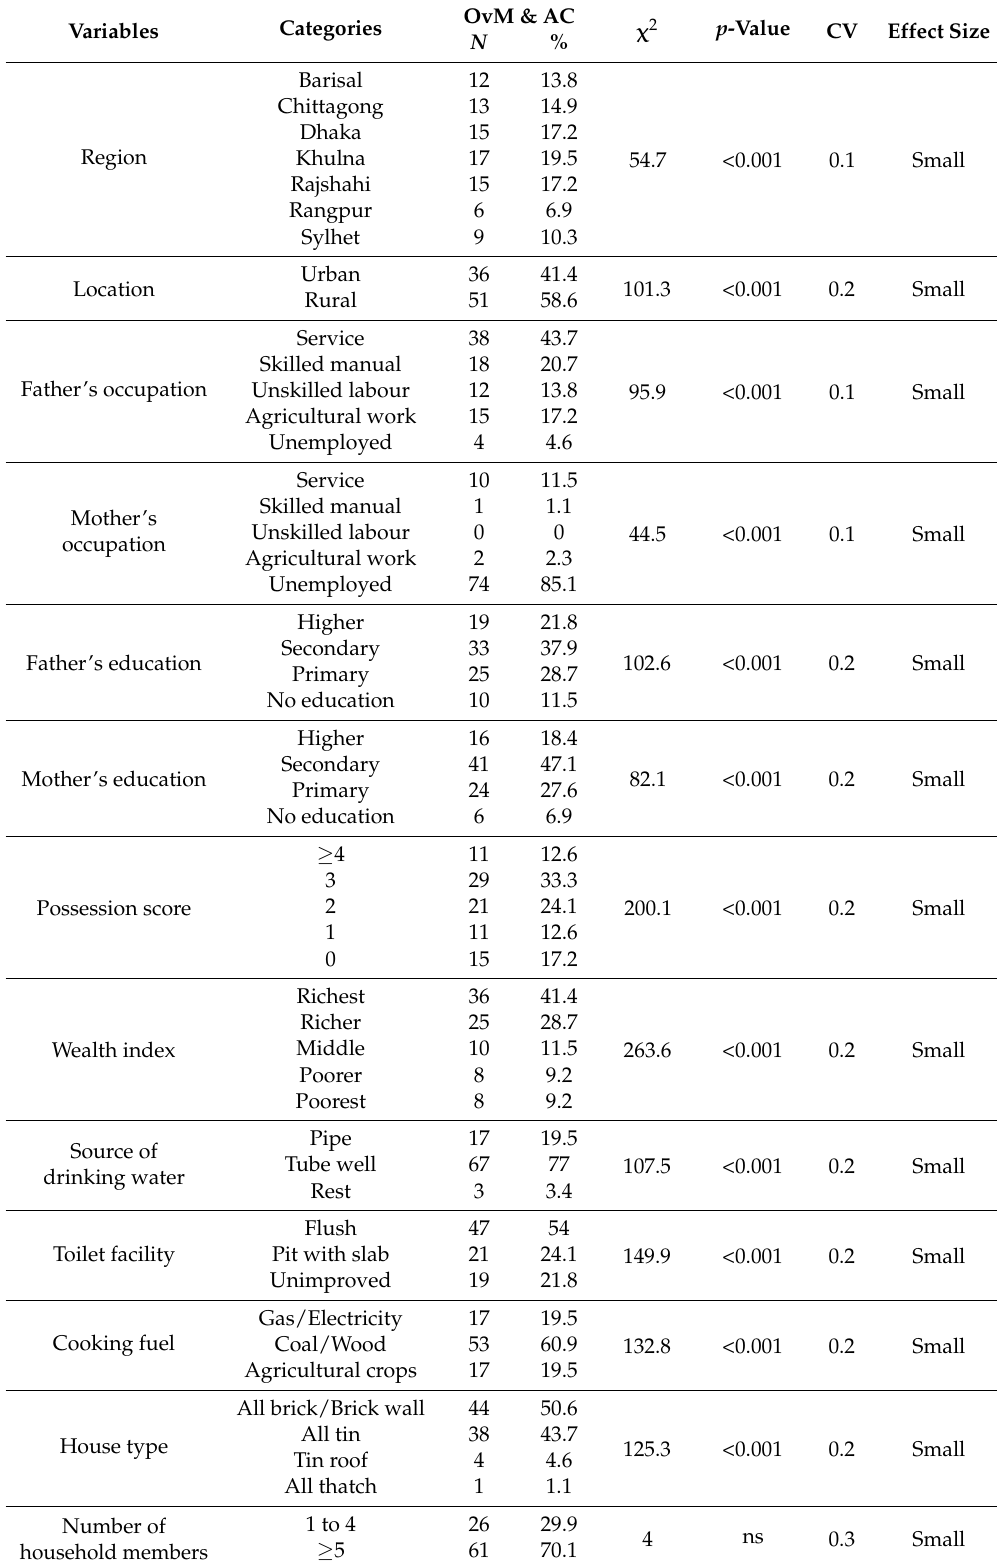
Table 7. Prevalence of overweight mother and anaemic child pairs by socio-demographic variables.